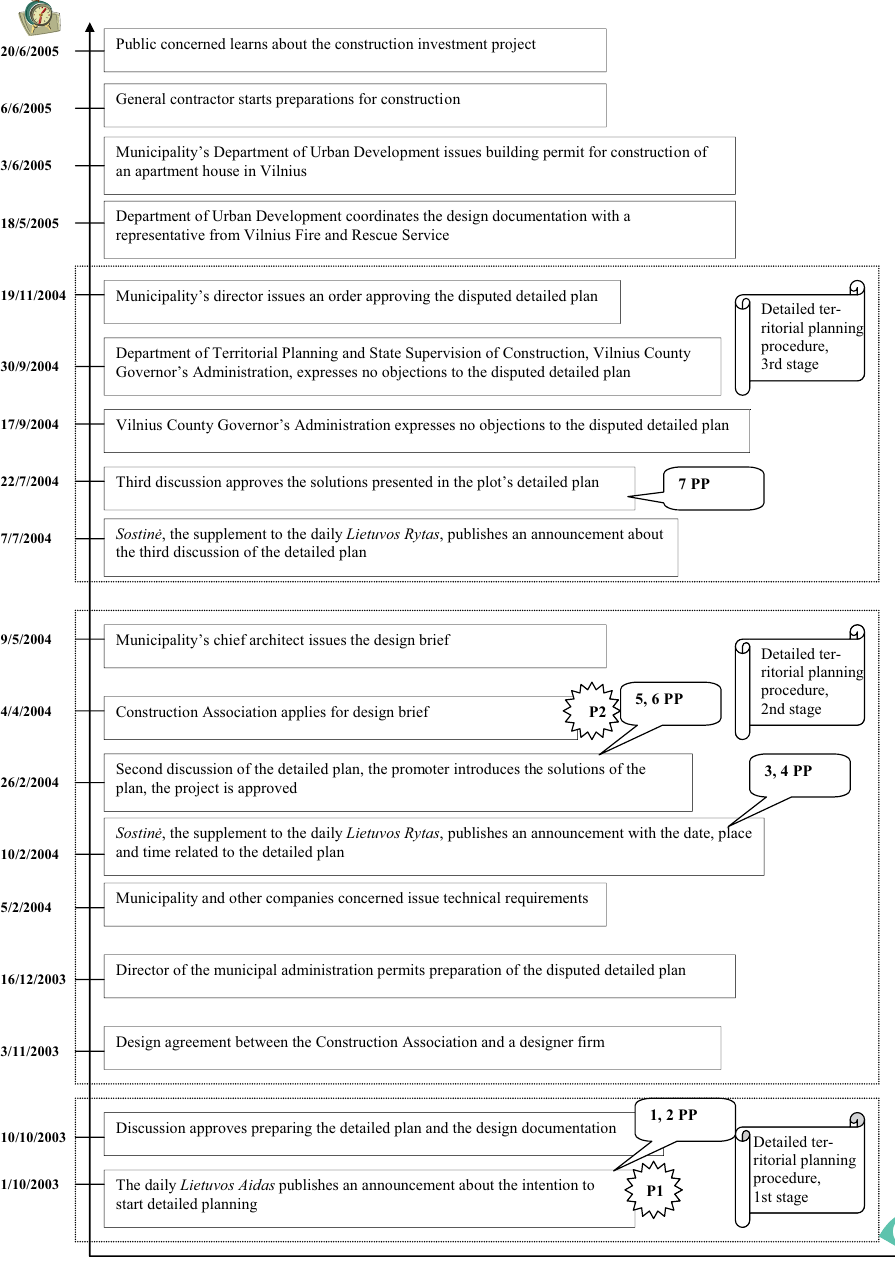
Fig. 2. Defence of infringed rights in an administrative court, an actual case (diagram compiled by the authors)